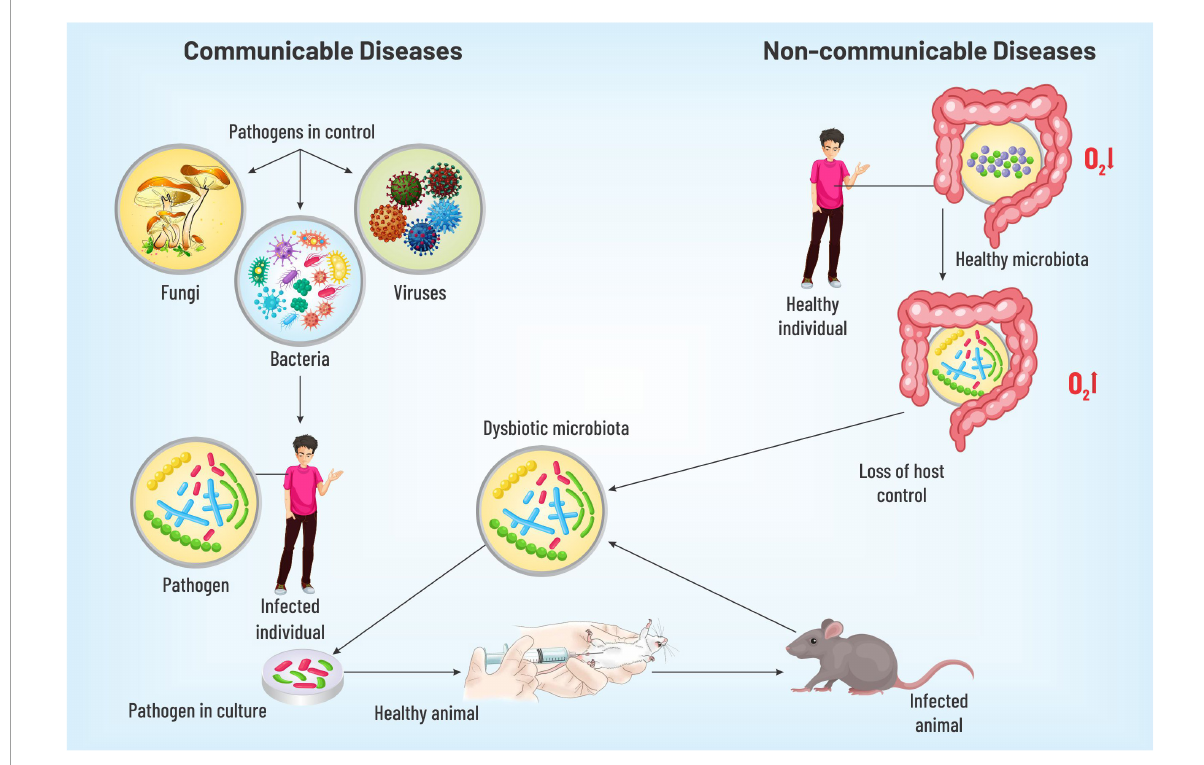
FIGURE1 A diagrammatic representation discussing the identification of pathogenesis for communicable and non-communicable diseases. The dysbiotic gut microbiota on injection into the healthy model organism isolated from individuals with NCDs was observed to cause the respective disease thus verifying the hypothesis of gut microbiota playing a key role in disease